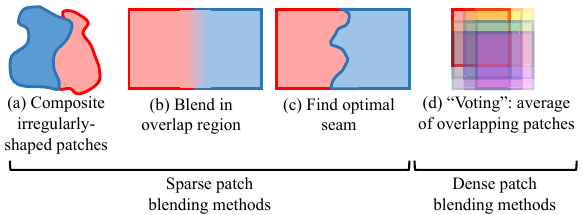
(a) Composite (d) “Voting”: average (b) Blend in (c) Find optimal irregularly- of overlapping patches overlap region seam shaped patches Sparse patch Dense patch blending methods blending methods Fig. 3 Blending methods for patch-based synthesis. Left: three methods for blending sparse patches, i.e., patches having a relatively small overlap: (a) irregularly-shaped patches can be composited [3], (b) overlapping patches can be blended in the overlap region [4], or (c) optimal seams can be found to make a hard cut between patches. Right: (d) shows a method for blending densely overlapping patches, where a patch is defined around every pixel: an average of all overlapping colors is computed by a voting process [6,